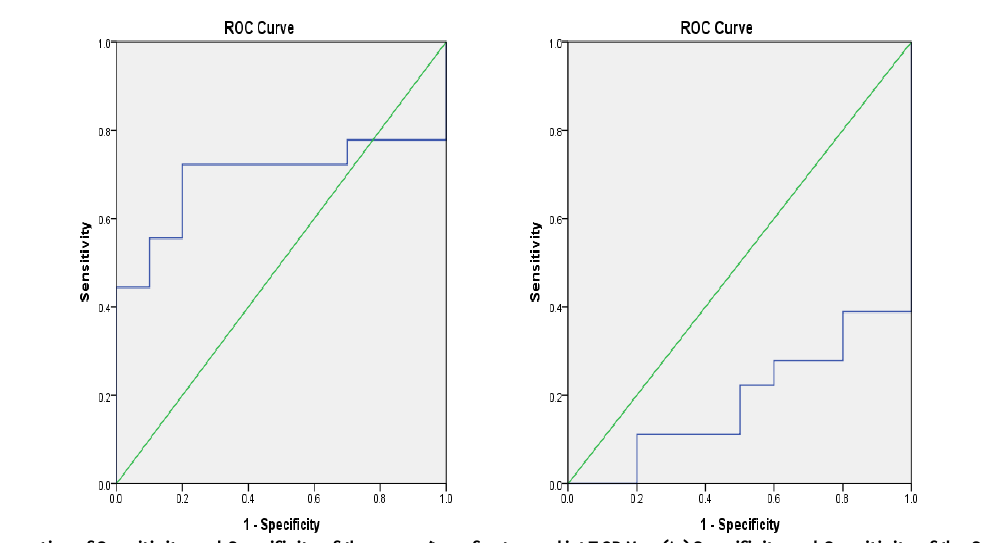
Figs. 4b. Comparative of Sensitivity and Specificity of the genus/taxa for to predict T2DM, (A) Specificity and Sensitivity of the Serratia to predict T2DM, (B) Specificity and Sensitivity of the Coprococcus to predict T2DM, (C) Specificity and Sensitivity of the Parabacteriodes to predict T2DM, (D) Specificity and Sensitivity of the Bifidobacteria for the Prediction of